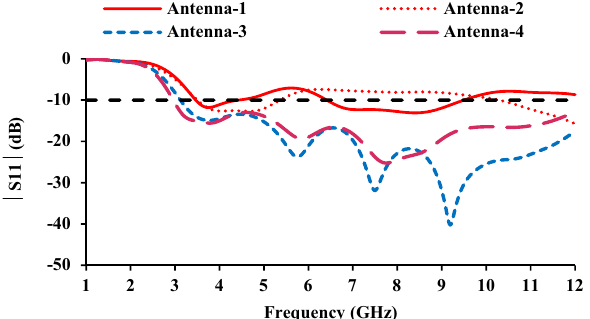
Figure 3. Reflection coefficients of the design steps.